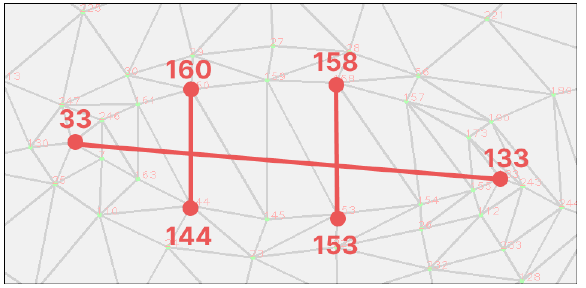
Figure 1. MediaPipe Facemesh Left Eye Landmarks for calculating Eye Aspect Ratio EAR